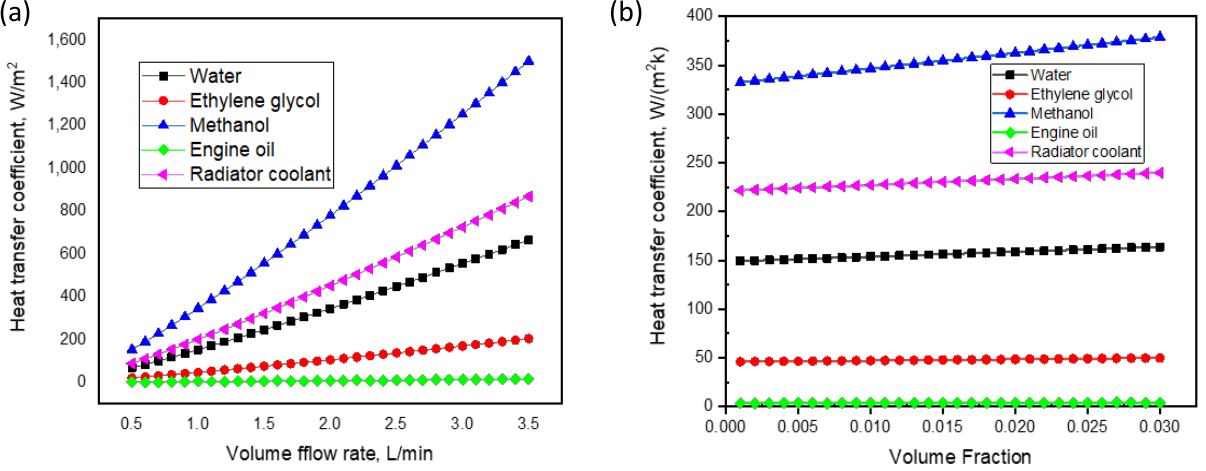
Figure 5. Variation of heat transfer coefficients with ( a ) volume flow rate and ( b ) volume fraction. The fluctuation of the heat transfer coefficient with volume percent for various hybrid nanofluids is shown in Figure 5b. According to Equation (20), the Nusselt number and the thermal conductivity of the nanofluid influence the heat transfer coefficient. The Reynolds number and the density of the nanofluid are connected to the Nusselt number. Equation (28), derived from the Hamilton and Crosser model [59], states that the volume fraction and form of the nanoparticles have a direct impact on the nanofluid’s thermal conductivity. The volume fraction has a linear relationship with thermal conductivity [60].